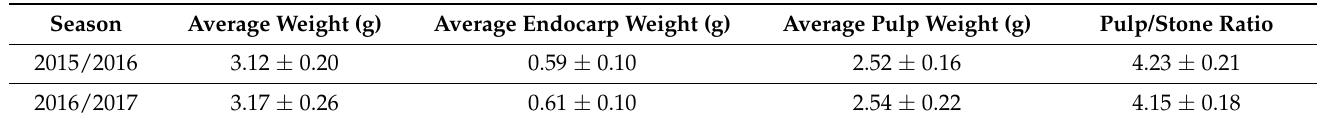
Table 1. Mean values and standard deviation of the biometric parameters evaluated in the fruit and the pulp/stone